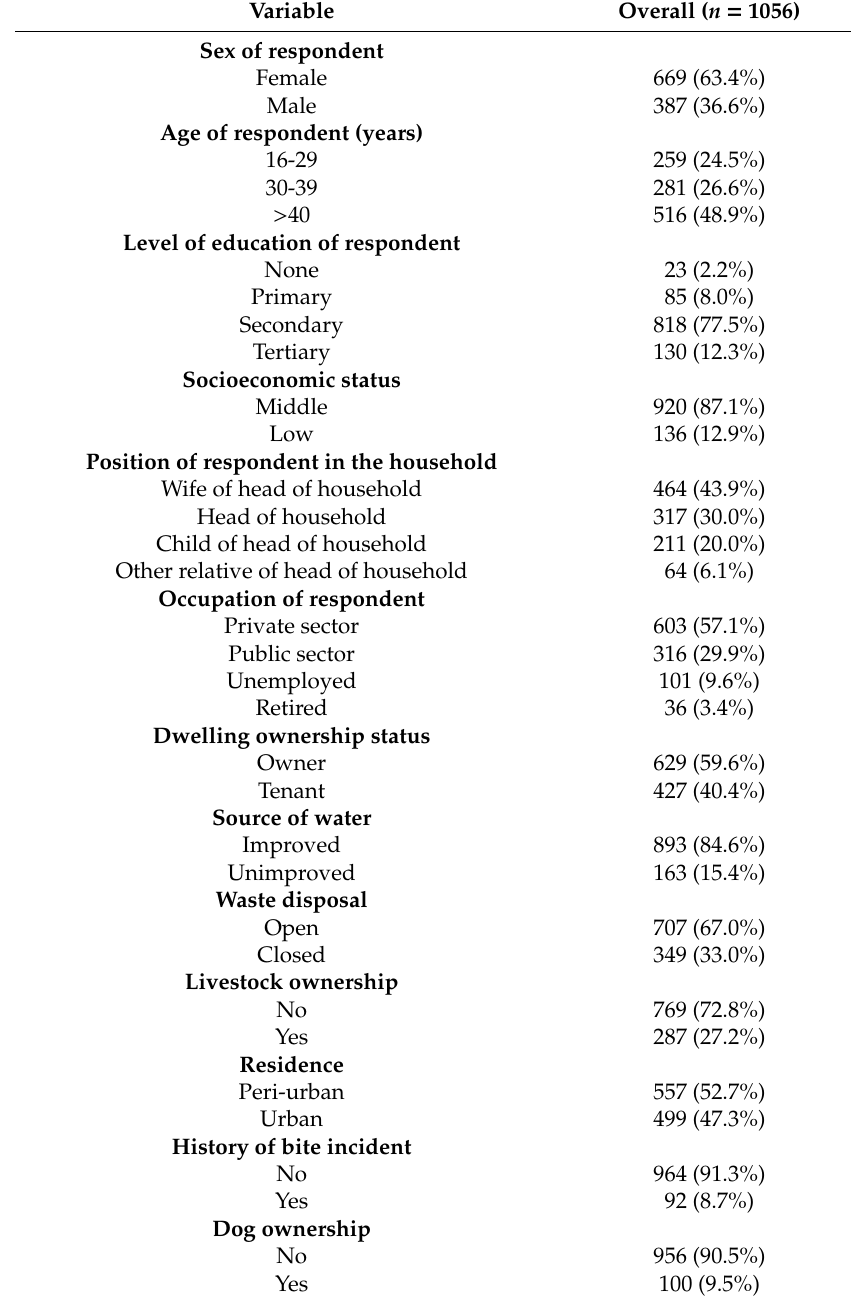
Table 1. Characteristics of the 1056 households and respondents surveyed in Matadi, Democratic Republic of the Congo (DRC) in May